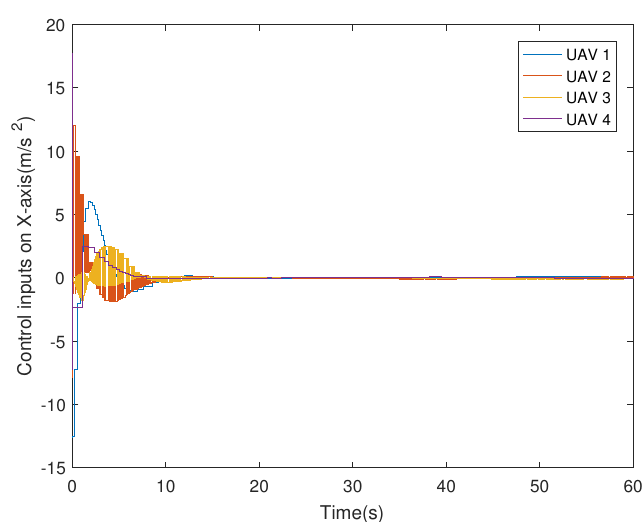
Figure 9. Triggering instants of UAV 4.